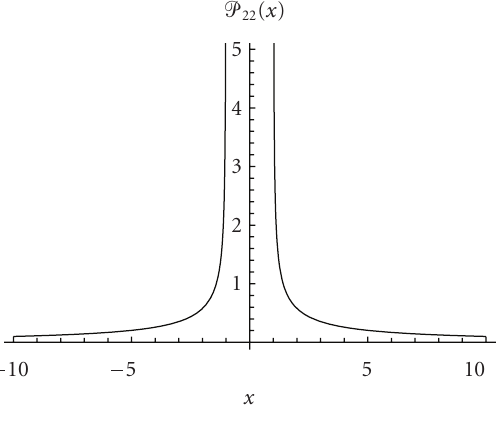
Figure 7.4. The function (cid:2) 22 ( b = 1, κ = − 1, b 4 =